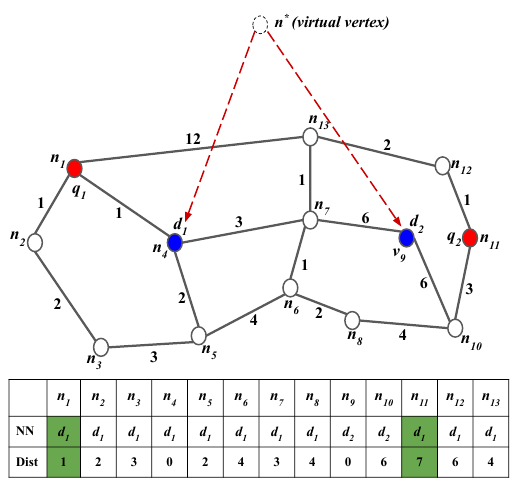
Figure 13. An example of VIVET at t i + 1 with updated distances, the green box indicates the query